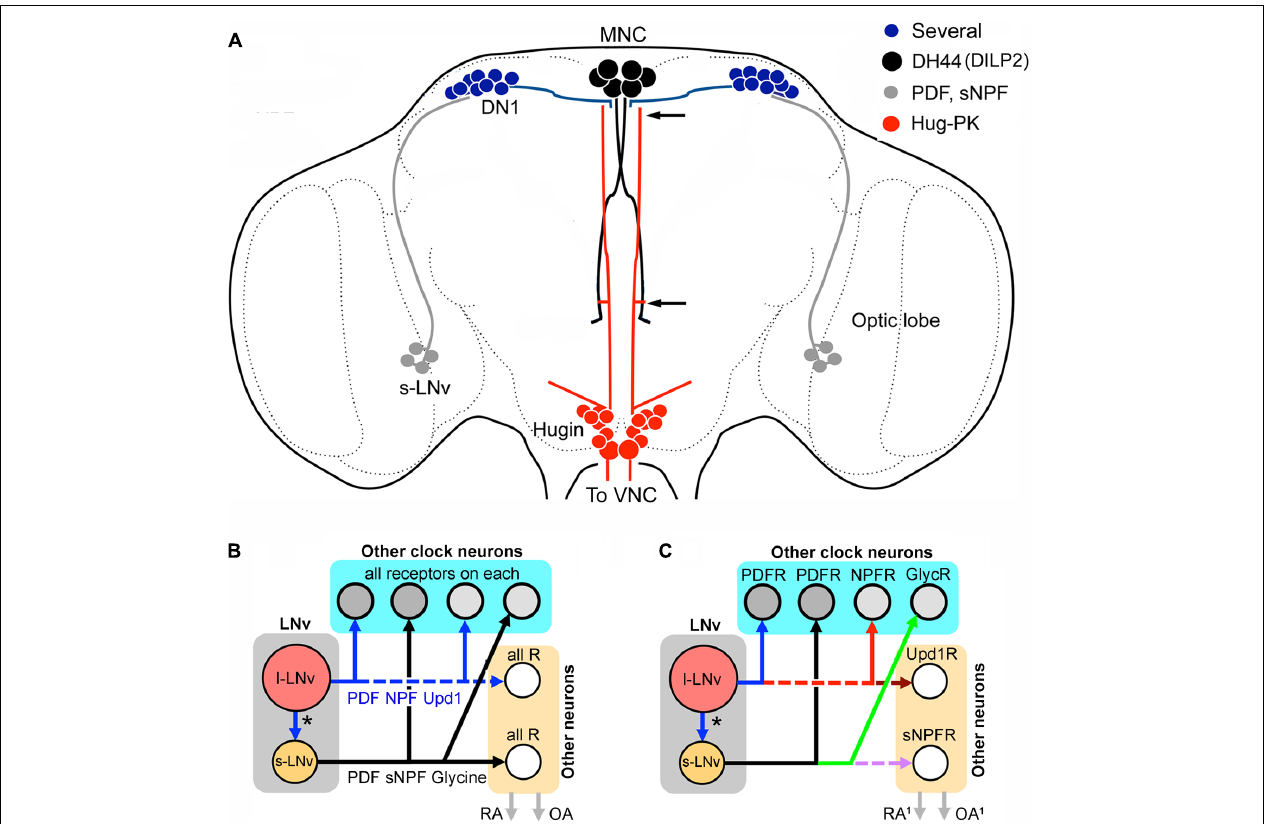
FIGURE 7 | Networks of peptide cotransmission in the clock circuits of Drosophila . (A) Neuronal circuit that regulates locomotor activity proposed in King et al. (2017). It was suggested that s-LN v s signal to DN1s that in turn act on DH44-producing MNCs. These signal with DH44 to hugin cells in the SEG via the DH44-R1. Some of the hugin cells have axons that terminate in the VNC where they contact glutamatergic neurons in motor centers that generate locomotion. The two arrows indicate areas where interactions between MNCs and hugin cells can occur. It is not known which peptide/neurotransmitter of the s-LNvs and DN1s that signal in this pathway. For s-LNvs it could be PDF, sNPF or glycine and for DN1s there are several candidate peptides (see Figure 5E ). Note that the MNCs also produce DILP2 (Ohhara et al., 2018). (B) The colocalized neuropeptides and other signaling molecules in the LN v s may target different constellations of neurons within and outside the clock circuitry; these are represented by “other clock neurons” and “other neurons,” respectively. The “other neurons” are effectors downstream to the clock circuits that regulate, e.g., rhythmic activity in behavior and physiology (RA), or neuronal systems that influence other behaviors such as reproduction, foraging and feeding (and indirectly metabolism), or produce systemic responses via hormone release (OA). In the simplest model, shown in (B) , all the target neurons for the large and small LN v s express receptors for all of the signal molecules released. Thus, targets of s-LN v s within and outside the clock circuit would all express receptors (R) for PDF, sNPF and glycine, and targets of l-LN v s have receptors for PDF, NPF and Upd1 (unpaired-1). Each of the neurons would thus receive multiple complementary signals. (C) Hypothetically the target neurons of the LN v s could be more diverse and express only subsets of the relevant receptors in different combinations. In this extreme example each target neuron type expresses only one receptor type and the downstream circuits could generate neuropeptide and signal substance-specific activity. Here, activity in, e.g., s-LN v s would simultaneously generate a more diverse set of actions within and outside the network. These could include some actions that are targeted only to neurons outside the bona fide clock network (e.g., the Upd1 or sNPF actions in this example). The outputs, RA 1 and OA 1 , could be more